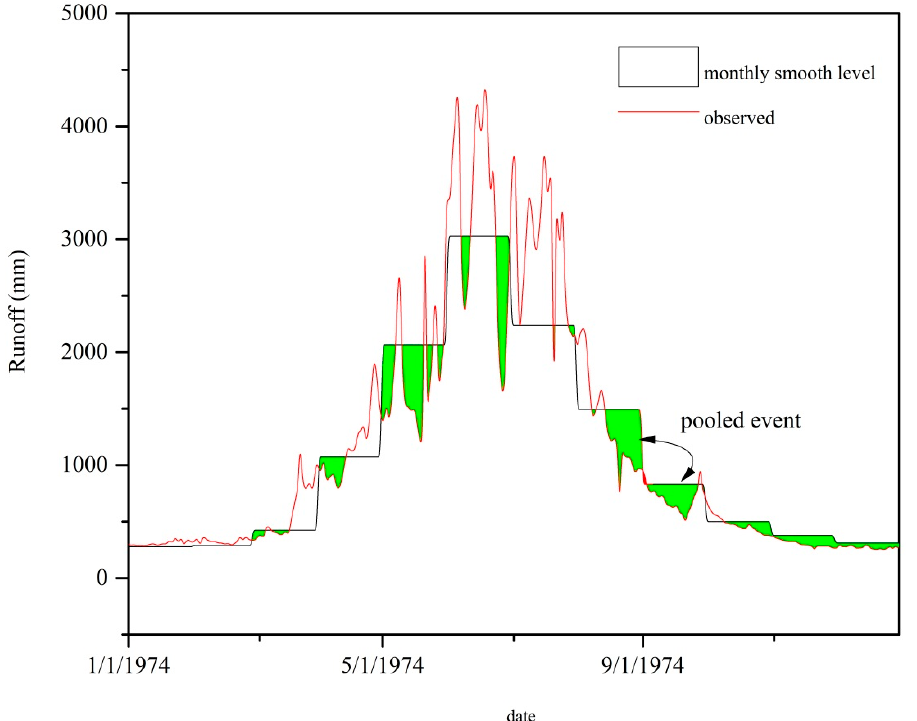
Figure 6. Transient threshold variable method for analyzing pooled events for the daily hydrological data.